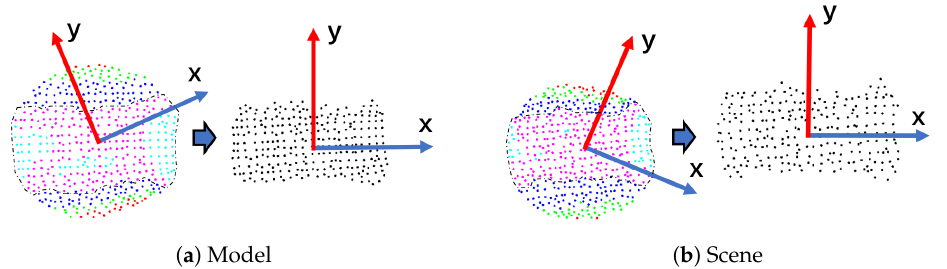
Figure 2. A brief view of the SliceLRF. ( a , b ) On the left is the 2D point data after the local point cloud is projected along the Z-axis, and the X-axis and Y-axis are obtained by covariance analysis. On the right is the estimation result of the SliceLRF, where the point data are the point cloud within the dotted line in the left subfigure. Red, green, dark blue, light blue, and purple express, respectively, slices